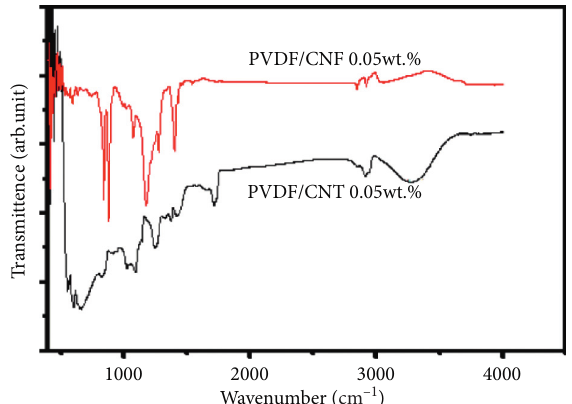
Figure 5: FTIR of PVDF/CNF and PVDF/CNT composite.